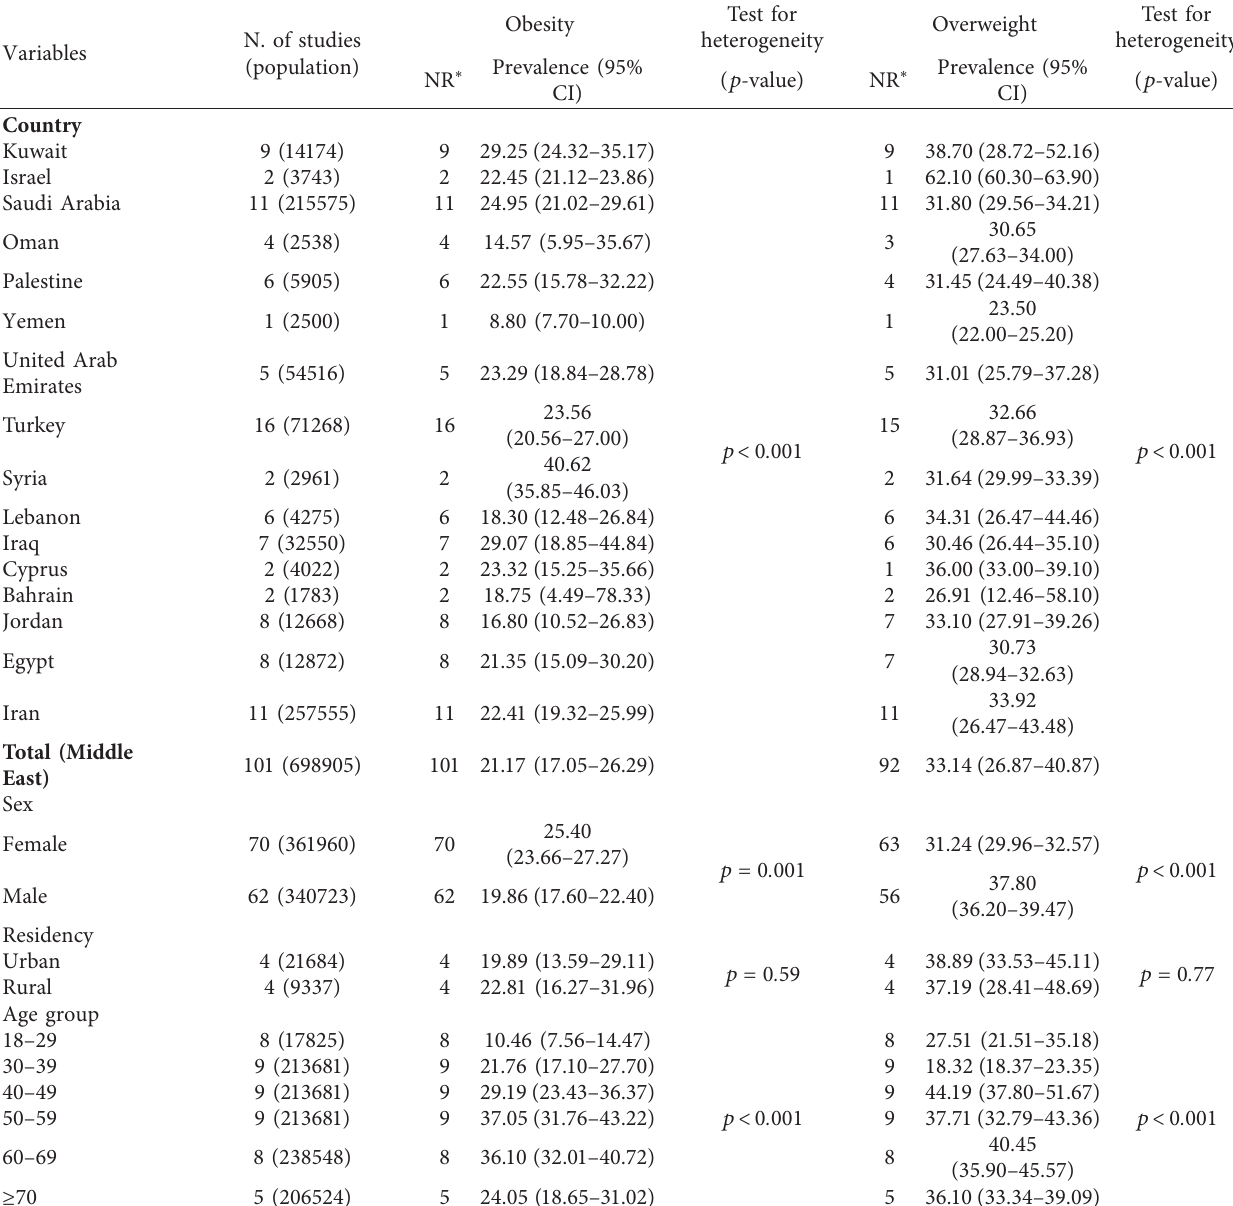
Table 2: The prevalence of obesity and overweight in the Middle East